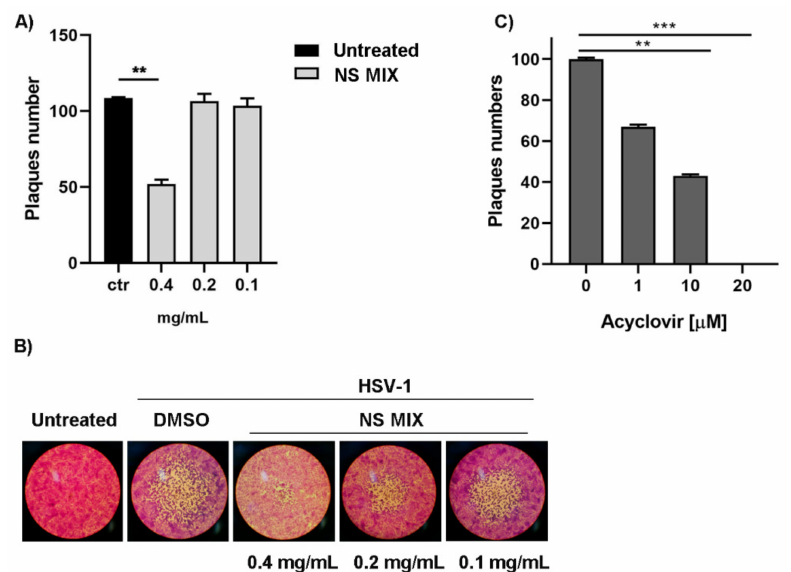
Figure 2. Antiviral activity of NS MIX. Vero cells were pre-treated with 0.4, 0.2, and 0.1 mg / mL of NS MIX for 1 h and the cells were then infected with Herpes simplex virus type 1 strain F (HSV-1) for 1 h at 37 ◦ C under gentle shaking. After incubation, the inoculum was removed and the cells were covered with medium containing 0.8% methylcellulose in the presence of NS MIX at 0.4, 0.2, and 0.1 mg / mL, separately. After three days the cells were fixed and stained with crystal violet and the plaques were visualized with an inverted microscope. ( A ) Plaque reduction assay following the NS MIX treatment. ( B ) Plaque morphological change due to the NS MIX treatment. Results are the mean of three biological independent experiments ± SD for each dilution. ( C ) Antiviral activity of acyclovir was tested in Vero cells infected with HSV-1 and incubated with medium containing 0.8% methylcellulose in the presence of acyclovir at 1, 10, and 20 µ M. The cells were stained with crystal violet for plaque counting and detection. Data are expressed as a mean ( ± SD) of at least three experiments and asterisks (**, ***) indicate the significance of p -values less than 0.01, and 0.001,